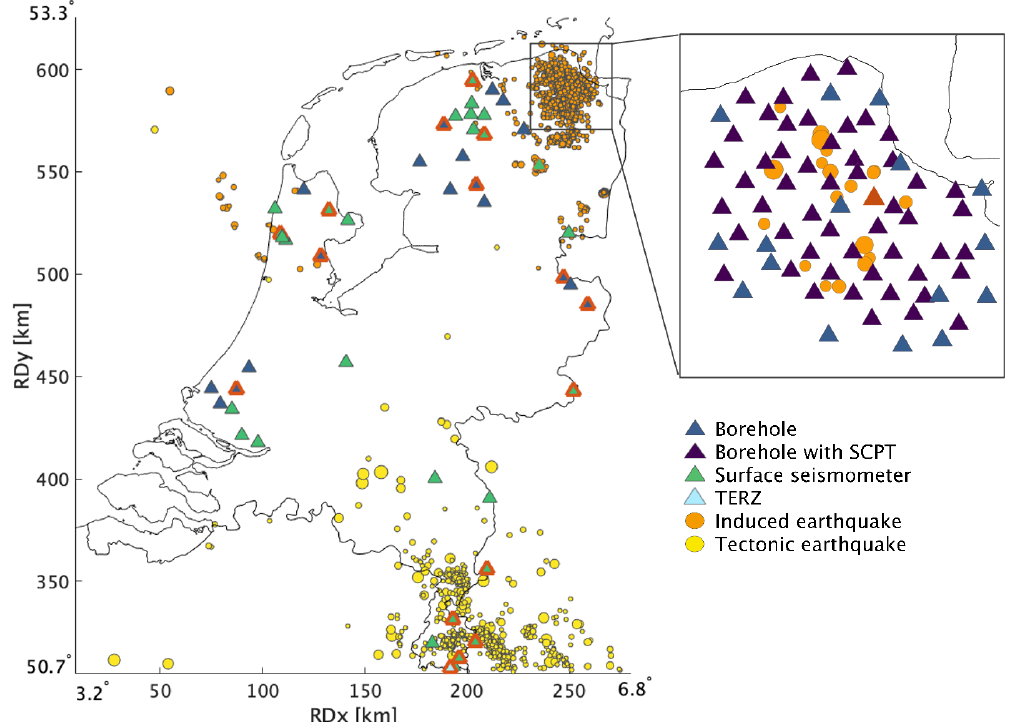
Figure 2. Map of the Netherlands depicting epicentres of all induced ( M w 0.5–3.6, orange) and tectonic ( M w 0.5–5.8, yellow) earthquakes from 1910–2020. The diameter of the circles indicates the relative earthquake magnitude. The triangles represent the surface location of the borehole stations (blue), borehole stations with SCPT measurements (purple), and single surface seismometers (green). The triangles with red outlines depict the locations of example HVSR curves presented in Fig. 8. The inset in the northeast depicts the location of the Groningen borehole network (G-network). Here, the red triangle depicts the location of borehole G24. The 19 ( M w ≥ 2) induced earthquakes in this panel are used for the AF and ETF computations. Coordinates are shown within the Dutch national triangulation grid (Rijksdriehoekstelsel or RD), and lat–long coordinates are added in the corners for international